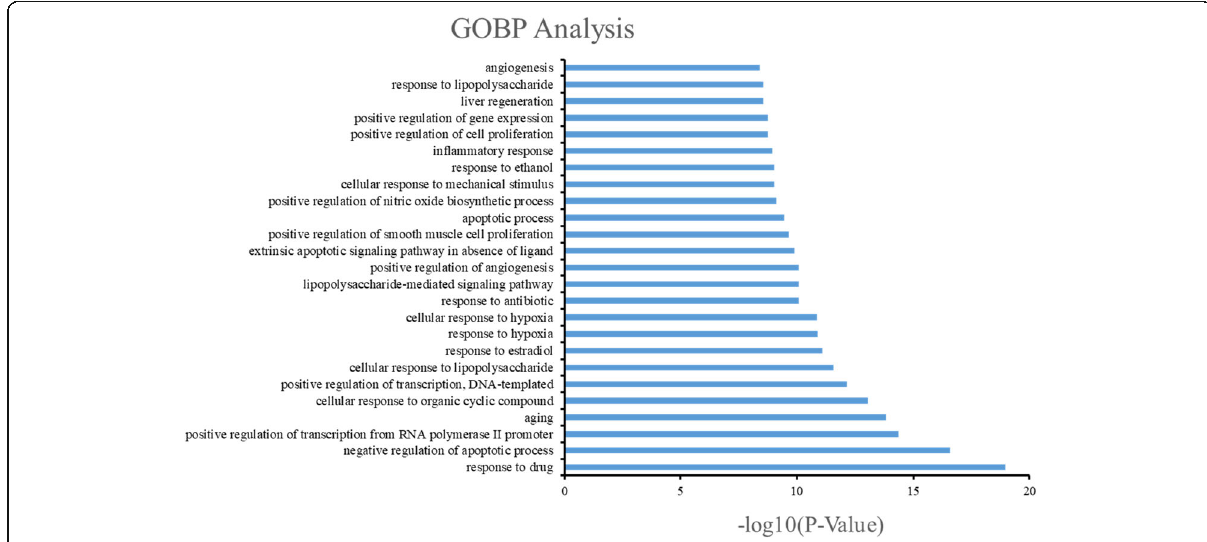
Fig. 7 The GOBP enrichment analysis of 77